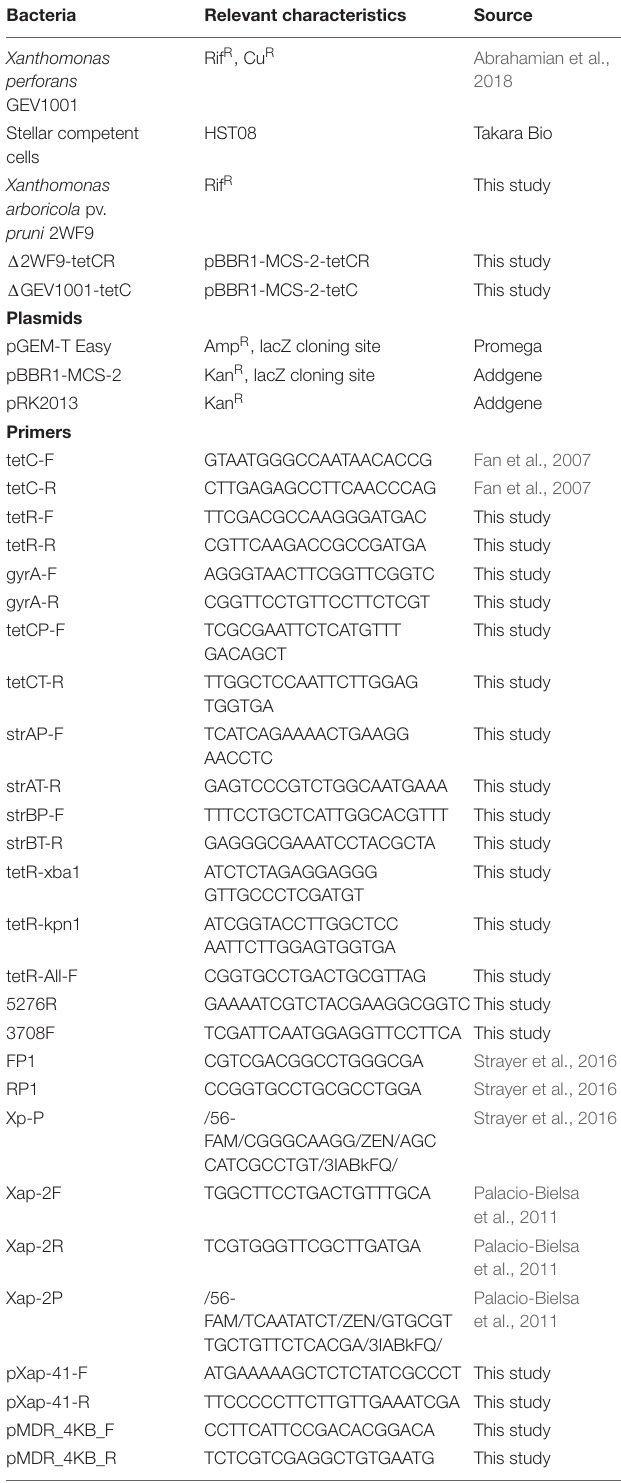
TABLE 1 | Bacterial strains, plasmids, and primers used in this